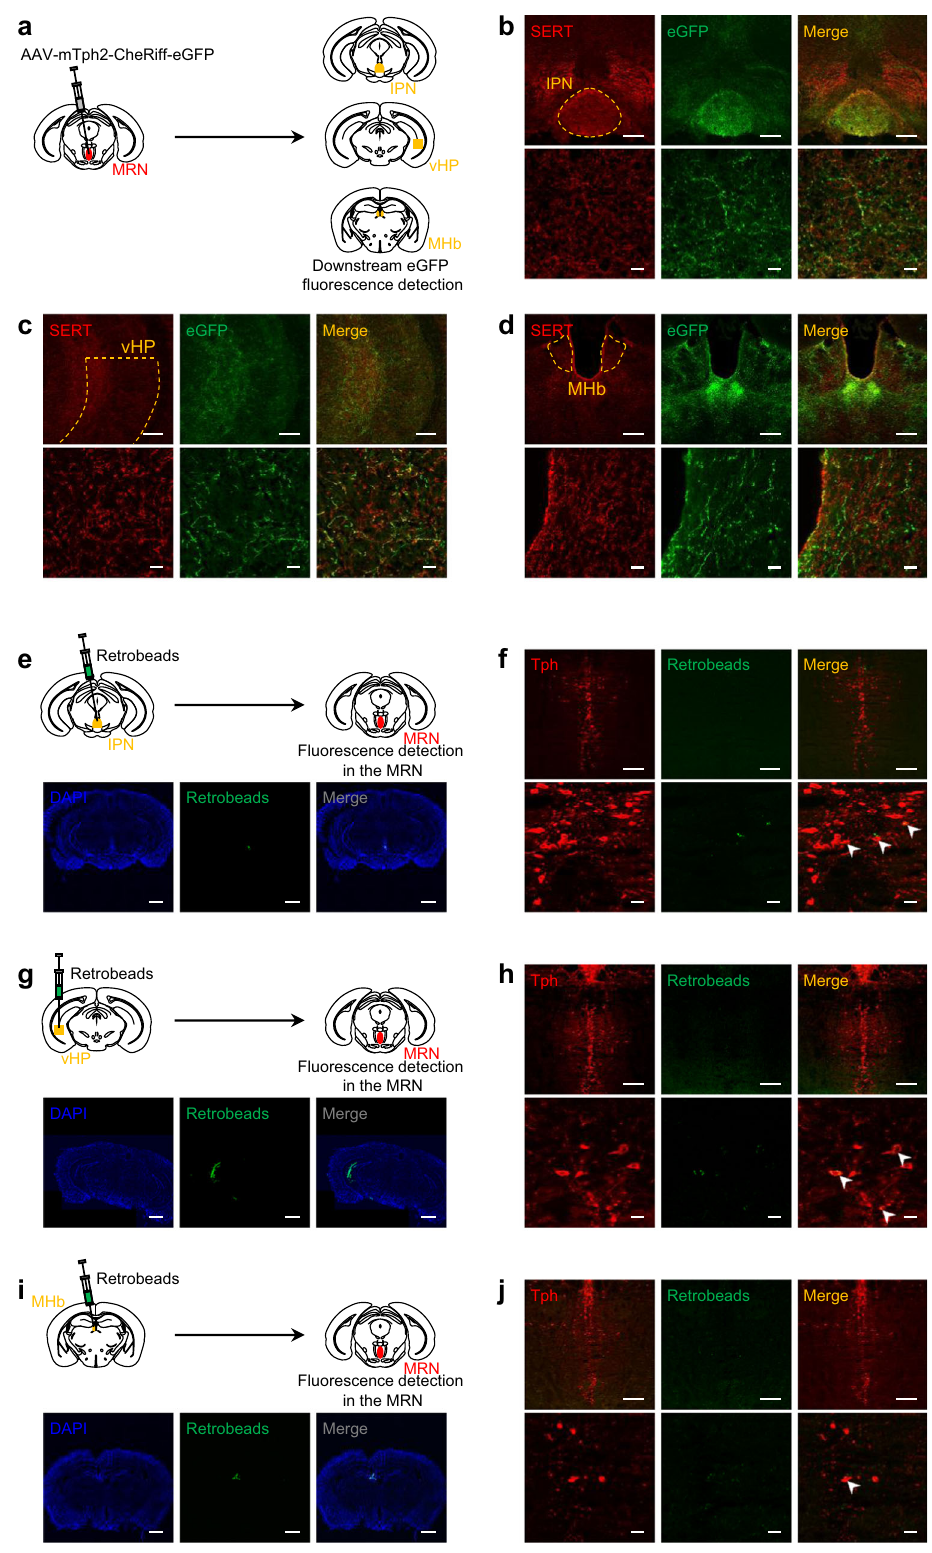
Fig. 5 | Identi fi cation of serotonergic projections from the MRN. infused with Retrobeads into the IPN ( e , f ), vHP ( g , h ), or MHb ( i , j ). Retrogradely labeled neurons in the MRN from IPN ( f ), vHP ( h ), or MHb ( j ) were visualized. Arrowheads=colocalized cells. Scalebars=1mm ( e , g , i ),200 μ m (top, f , h , j ),and 20 μ m (bottom, f , h , j